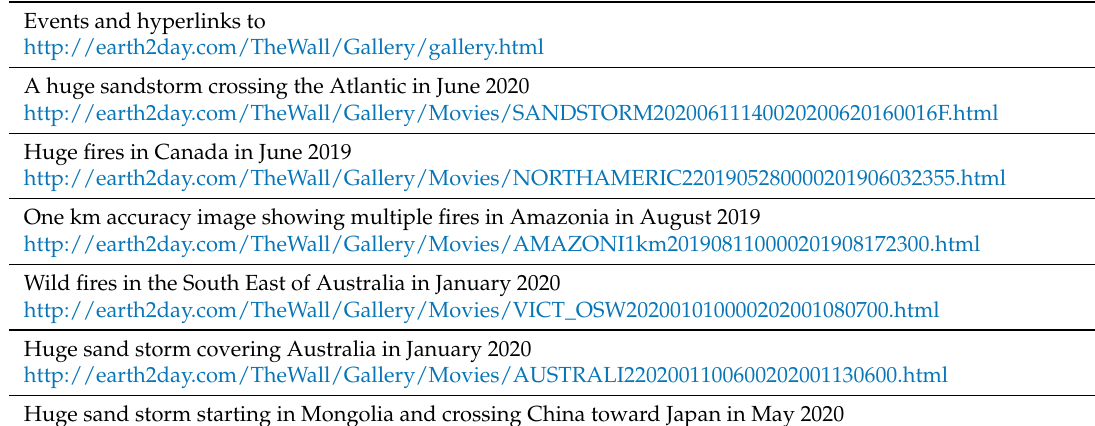
Table 3. List of events presented in “The Wall”